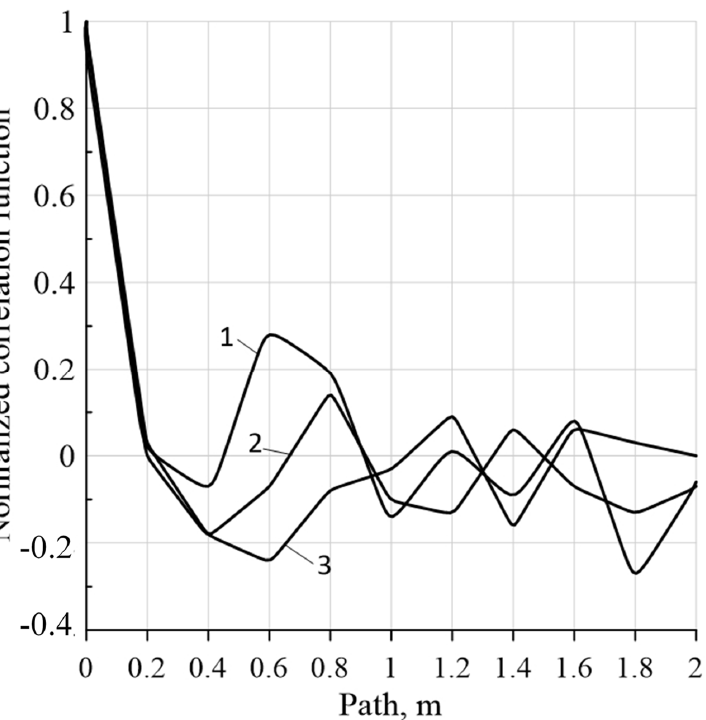
Figure 5. Normalized oscillation correlation functions of the cross profile of the field surface after plowing treatment: 1—PND-5-40; 2—PLN -5-35; 3—PNJA-4-42.